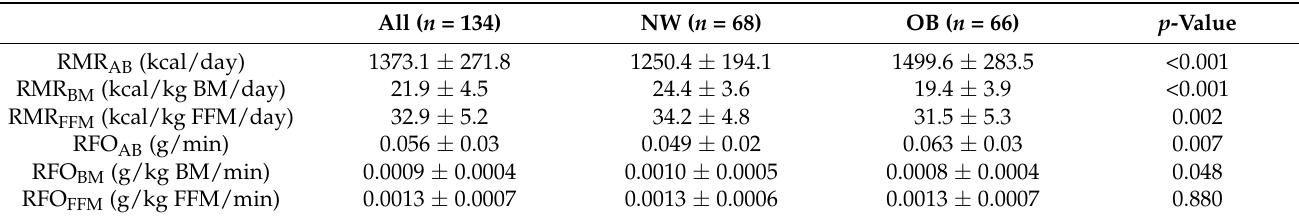
Table 1. Metabolism, aerobic capacity, oxidative stress, inflammation of the participants. All ( n =